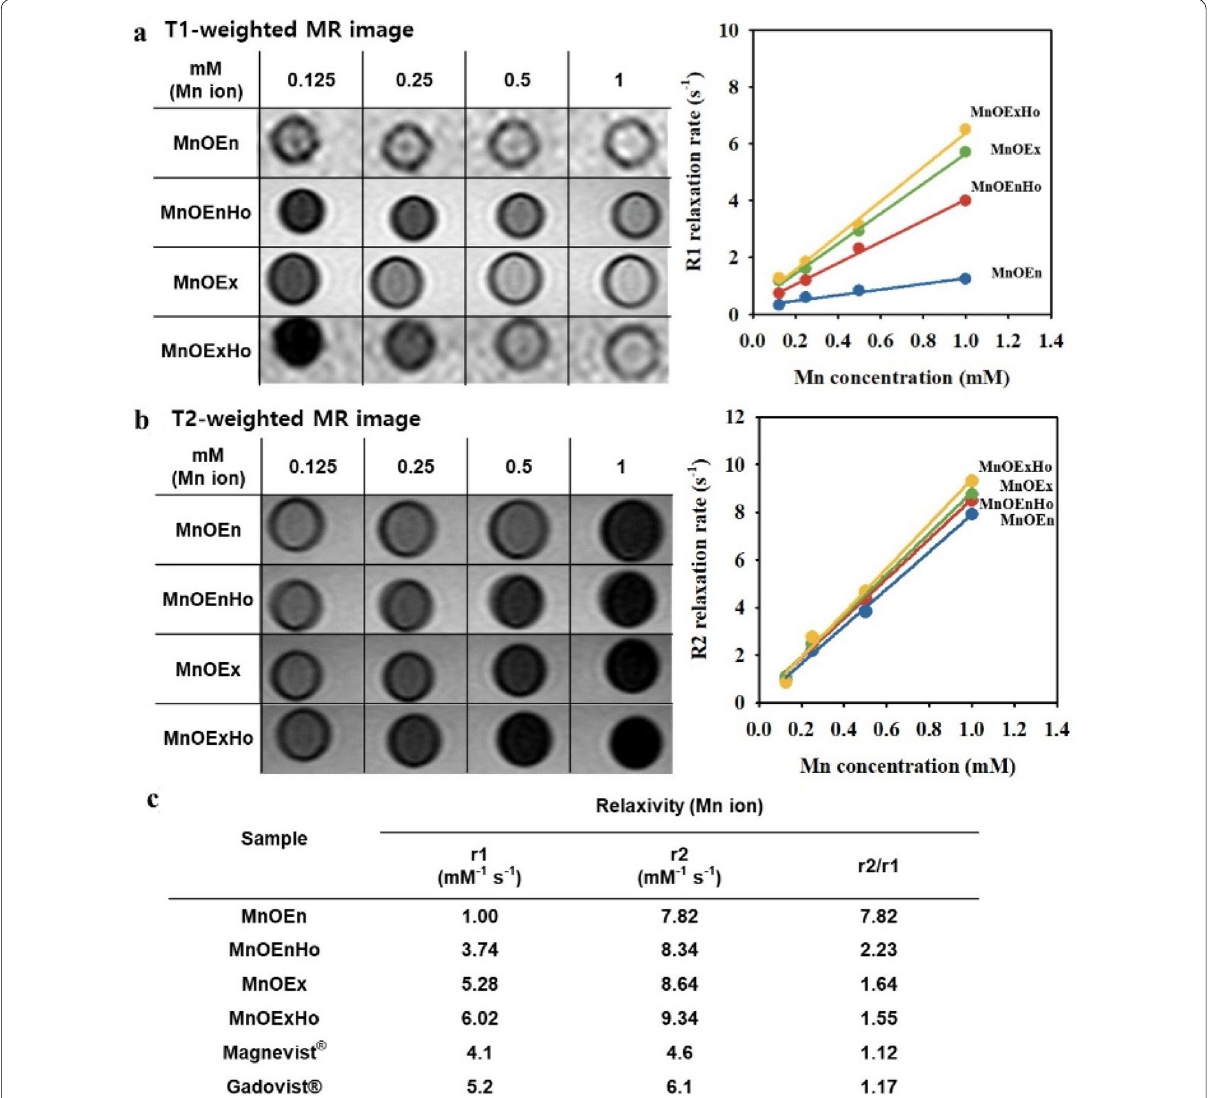
Fig. 5 a T1‑weighted MR images and b T2‑weighted MR images depending on the concentration of each particle and plots of each relaxation (1/ T1 and 1/T2) against Mn concentration. c Calculation of R1 relaxivity (r1), R2 relaxivity (r2) and r2/r1 [MnOEn (blue line), MnOEnHo (red line), MnOEx (green line), and MnOExHo (yellow